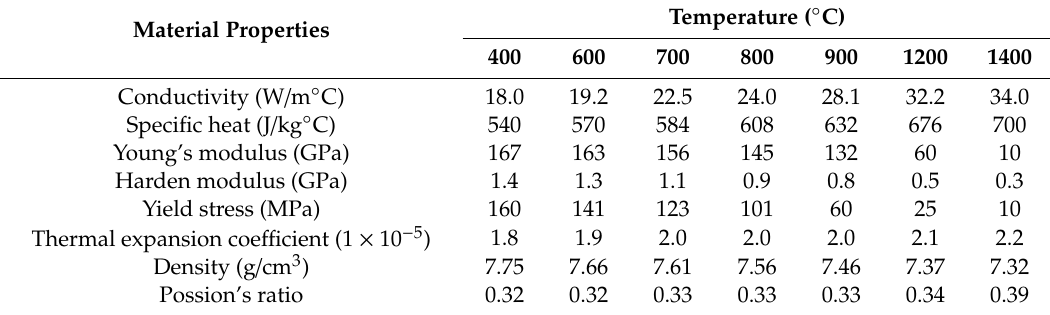
Table 2. Material properties of austenite/undercooled austenite.